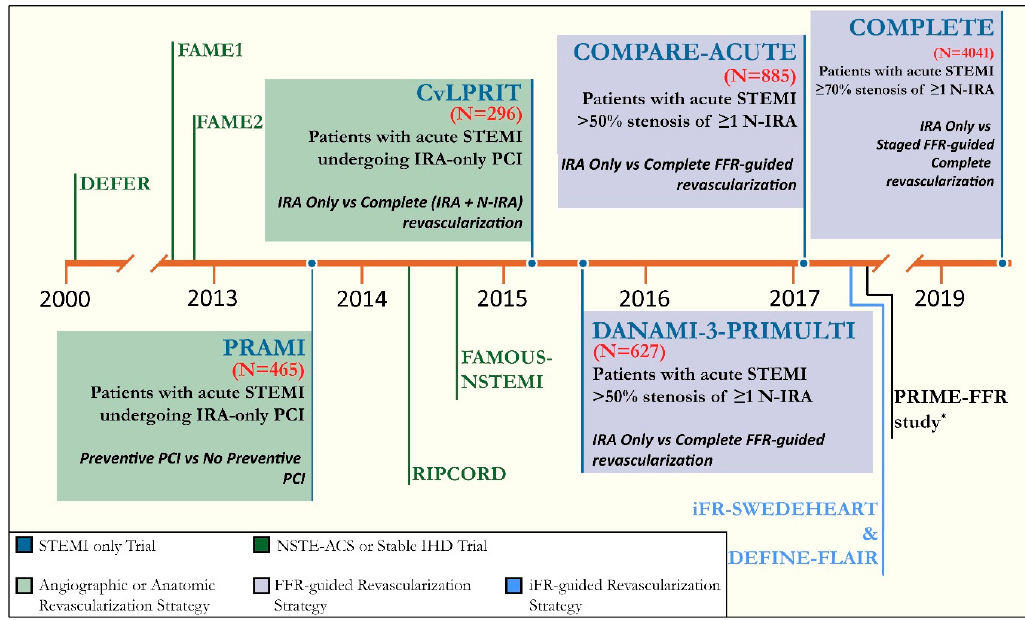
Figure 3. Timeline of Physiologic-Guided Landmark Clinical Trials in Acute Coronary Syndromes using Fractional Flow Reserve. (* prospective registry study). IRA = infarct-related artery; N-IRA = non-infarct-related artery; PCI = percutaneous coronary intervention; NSTE-ACS = non-ST-segment acute coronary syndromes; IHD = ischemic heart disease, FFR = fractional flow reserve, iFR = instantaneous wave-free ratio. FAME = FFR versus Angiography for Multivessel Evaluation. Table 2. Studies using Invasive Assessment of the Microcirculation in ST-segment myocardial infarction (STEMI) Immediately after Reperfusion.